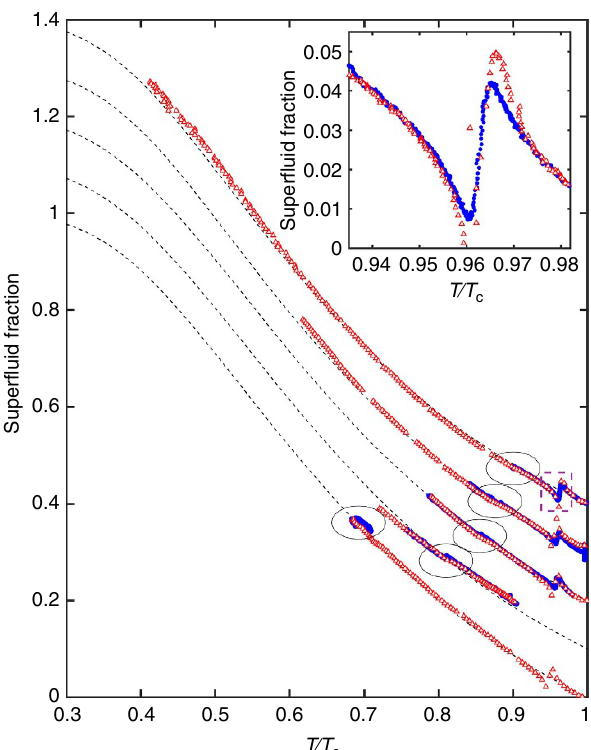
Figure 2 | Temperature dependence of the superfluid fraction. Superfluid fraction (each offset by 0.1 from adjacent results for clarity) measured at 0.1 (bottom), 1.4, 2.5, 3.6 and 5.6 bar (top) while warming (open red triangles) and cooling (filled blue circles) as a function of temperature measured in units of bulk superfluid transition temperature T c . Encircled are the locations of the A–B and B–A transitions, shown in detail in Fig. 3. Dashed lines show the superfluid density of the bulk B phase 54 . The anti-symmetric signature just below T c arises from a mode crossing of a Helmholtz resonance with the torsional mode (marked with a dashed box and shown in inset). The crossing is narrower after warming from the B phase into the A phase than after cooling from the normal fluid into the A